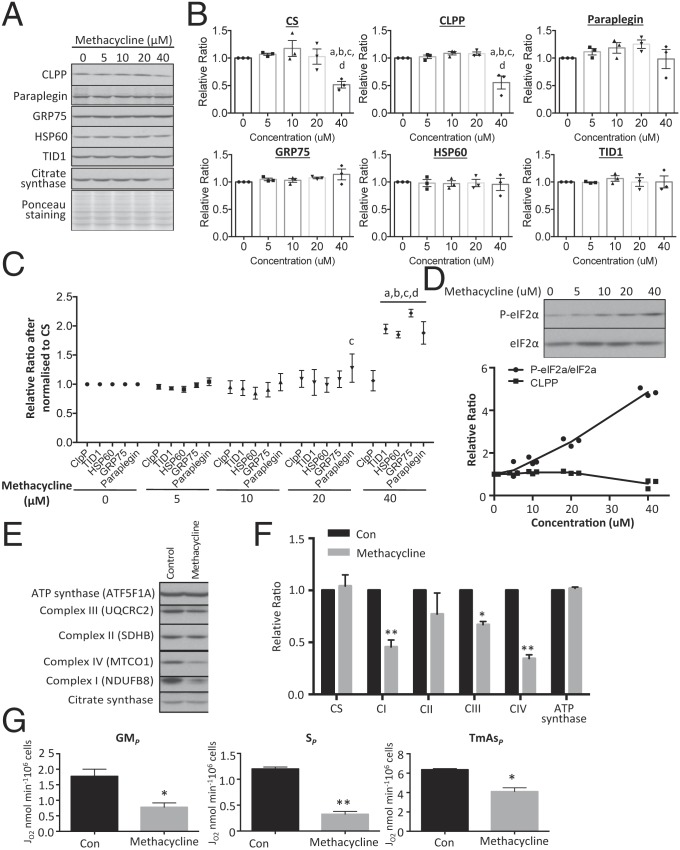
Activation of UPRmt impairs mitochondrial OXPHOS capacity. Cells were treated with the UPRmt inducer methacycline for 24 h or 72 h. (A–C) Methacycline suppresses levels of mitochondrial CS and CLPP proteases and ETC complex subunits but not chaperones and ATP synthase in a dose-dependent manner. (A) Expression of CLPP, paraplegin, TID1, HSP60, GRP75, and CS were measured by Western blot. (B) Band intensity of mitochondrial chaperones and OXPHOS complexes subunits was quantified before expressing as a relative ratio to untreated control, which was set as 1. (C) Data were normalized to CS before expressing as a relative ratio to untreated control, which was set as 1. In B and C, data are presented as mean ± SEM, n = 3, and were analyzed using a 2-way ANOVA with Tukey’s multiple comparison test. a, b, c, and d indicate statistically significant changes at methacycline concentrations of 0, 5, 10, or 20 μM, respectively. (D) Methacycline promotes phosphorylation of eIF2α. There was a dose-dependent increase of phosphorylation with increasing concentration of methacycline. The increase P-eIF2α is closely associated with the decrease of CLPP protein. Band intensity of P-eIF2α and eIF2α was quantified and the ratio between phosphorylated and total was calculated before expressing as a relative ratio to untreated control, which was set as 1. (E and F) Prolonged treatment wth methacycline inhibits expression of ETC complex subunits selectively. Cells were incubated with sublethal dosage of methacycline (20 μM) for 72 h. Data are expressed as relative ratio to the untreated control, which was set as 1, and are presented as mean ± SEM, n = 3. Ponceau S staining was used to show equal loading in Western blot. (G) Methacycline reduces OXPHOS capacity supported by substrates for N-pathway via complex I (GMP), S-pathway via complex II (SP), and nonphysiological electron donors to complex IV (TmAsP). Data are presented as mean ± SEM, n = 4, as the amount of oxygen being consumed by 106 of cells per min. For F and G, P < 0.05 is considered statistically significant. *P < 0.05; **P < 0.01 under 2-tailed paired Student’s t test.